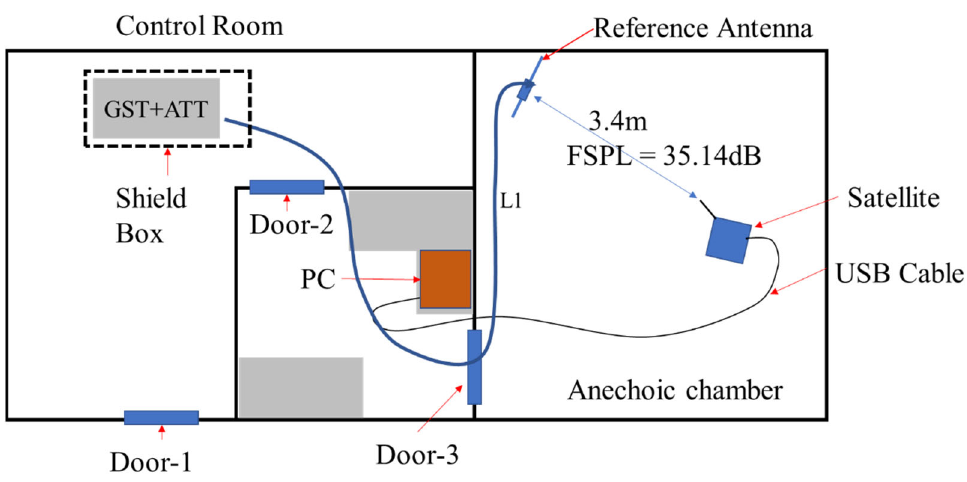
Figure 11. Test configuration for receiver sensitivity tests in an anechoic chamber.